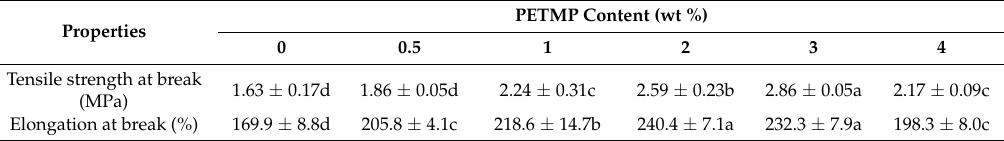
Table 6. The effect of PETMP content on tensile strength and elongation at